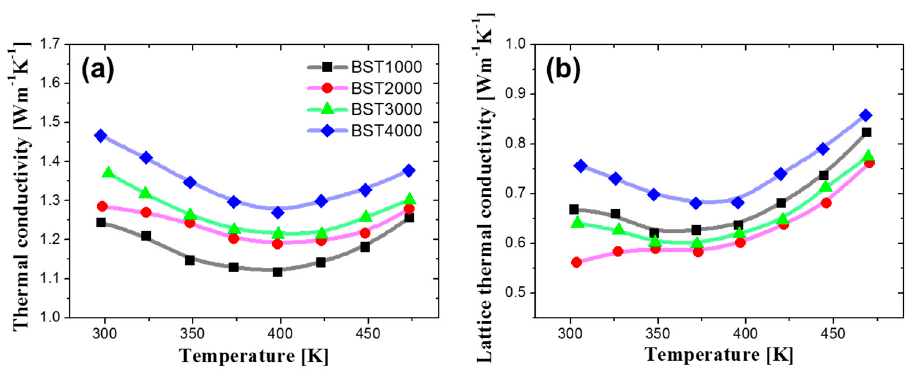
Figure 6. Temperature dependence of ( a ) total thermal conductivity ( κ ), and ( b ) lattice thermal conductivity ( κ lat ) for BST1000–BST4000 samples.